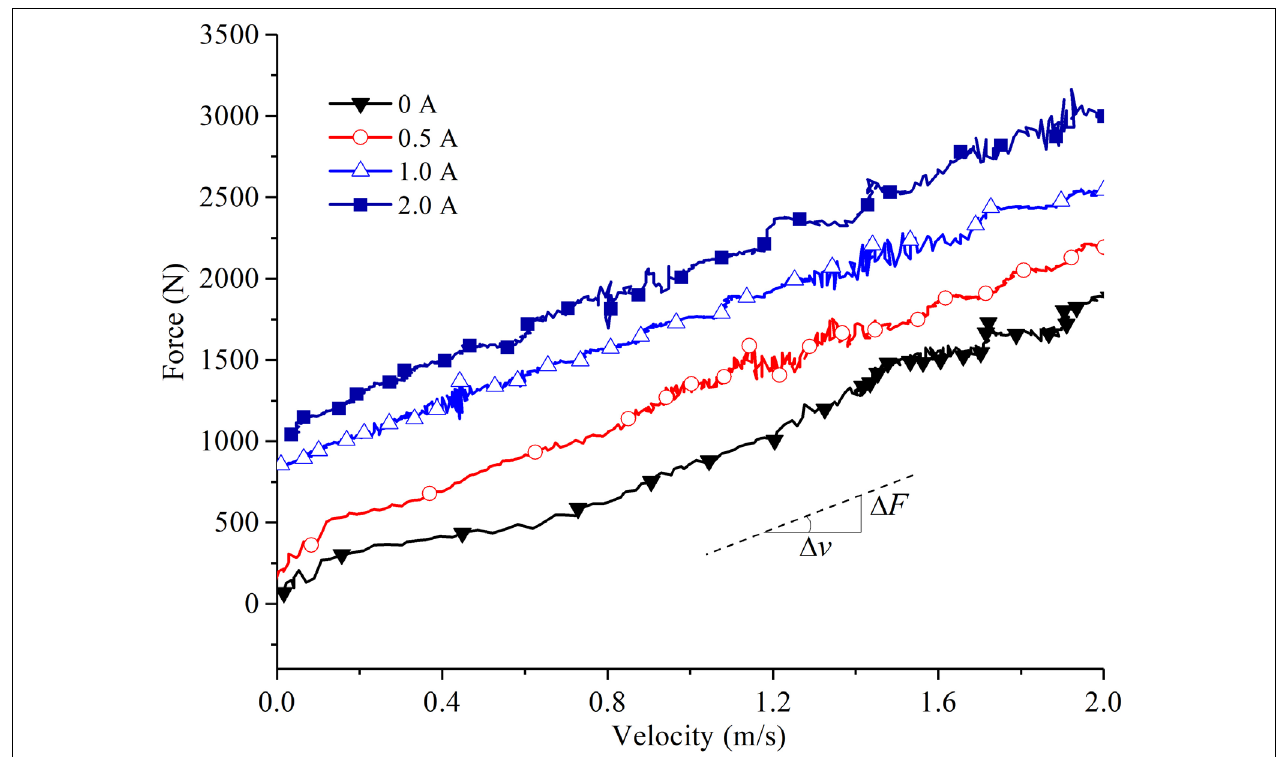
FIGURE 8 | Relationship between recoil force and velocity in stable impact